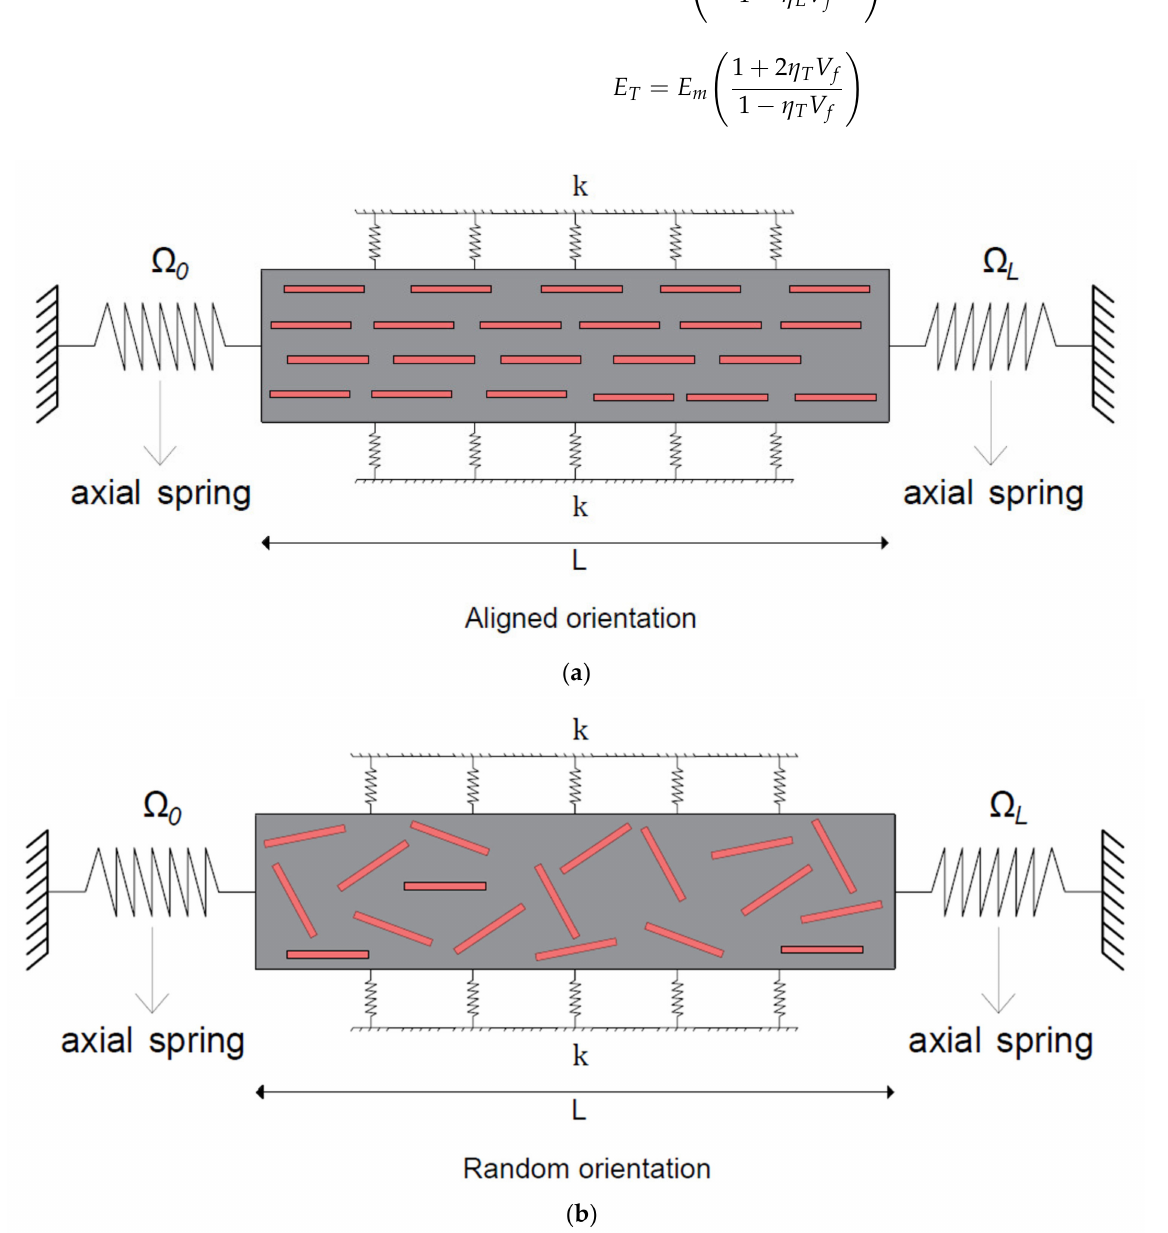
Figure 1. Illustrations of composite micro-/nano-rods with elastic springs: ( a ) aligned composite micro-/nano-rod; ( b ) randomly oriented composite